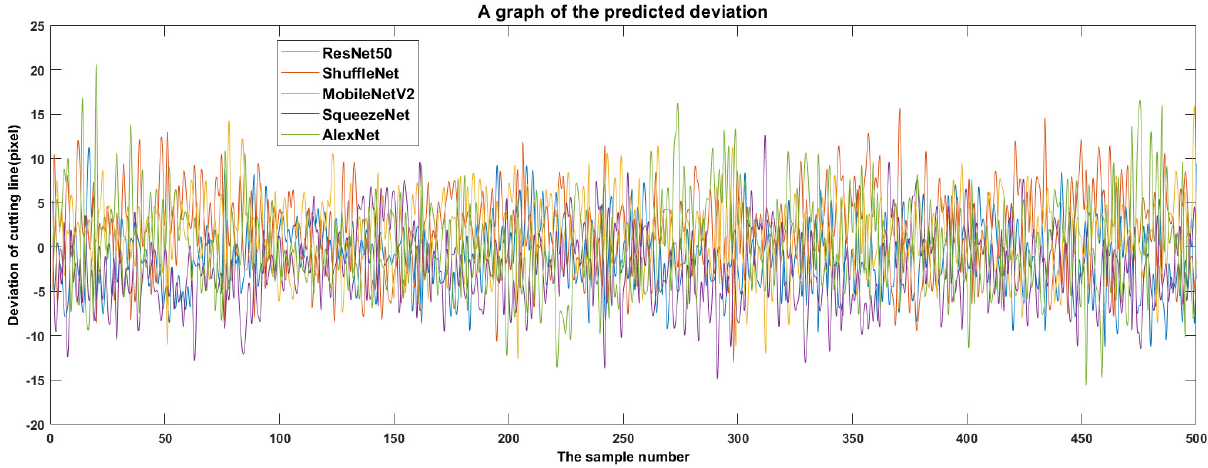
Figure 16. Cutting line position deviation predicted by different backbone networks.